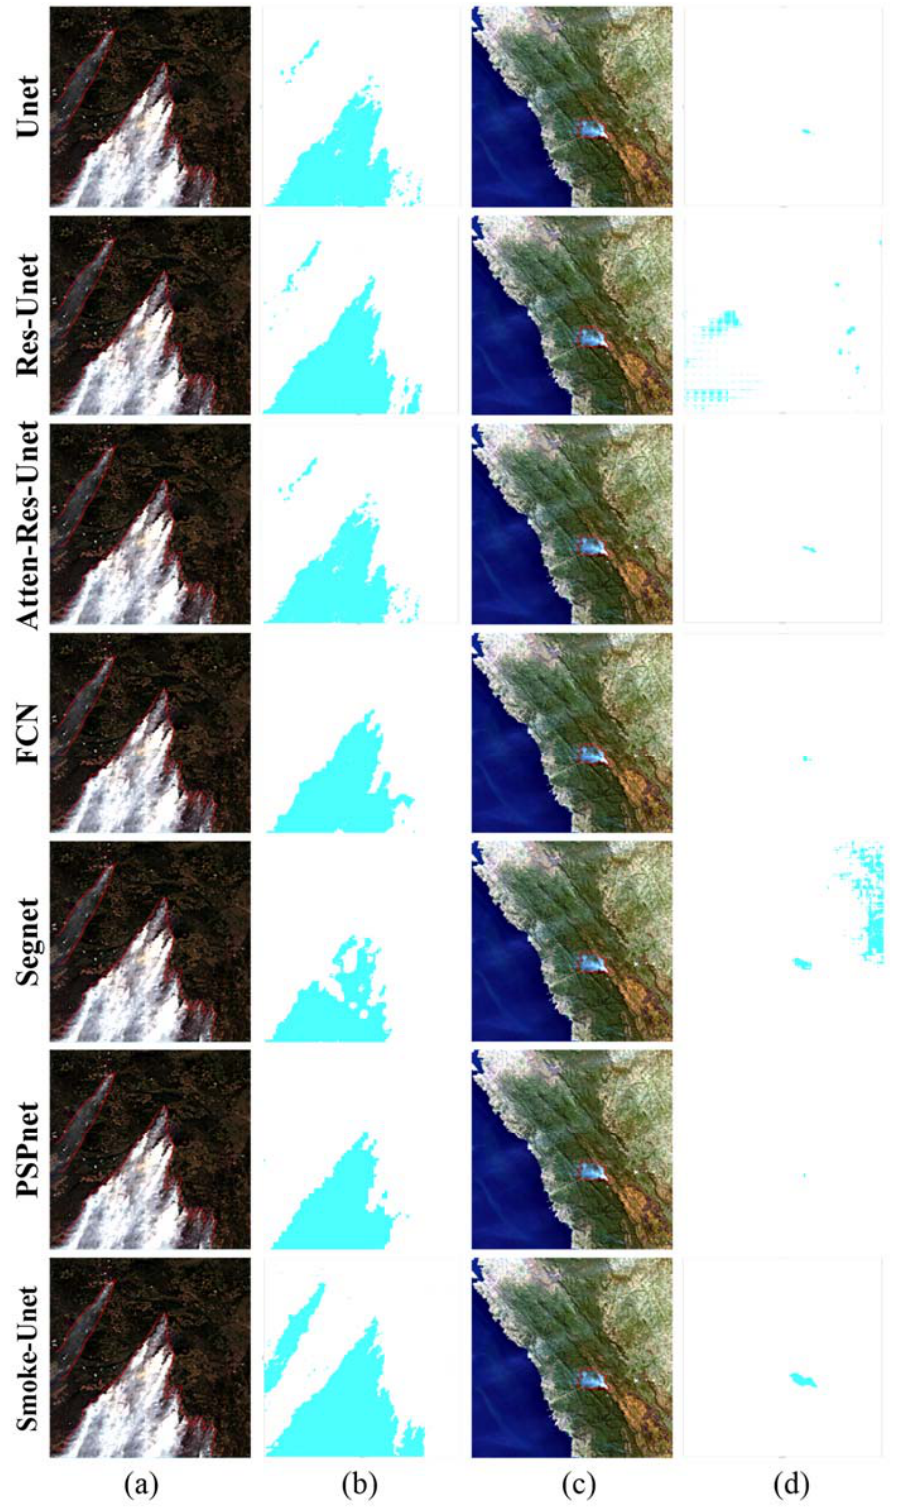
Figure 7. The results of segmentation of different networks. ( a ) Image acquired over British Columbia, Canada, on 4 August 2017, the smoke is depicted in red line area; ( b ) The segmentation results of smoke over British Columbia, the smoke pixels are depicted in aqua color; ( c ) Image acquired over New Zealand area, on 7 Feb 2019, the smoke is depicted in red line area; ( d ) The segmentation results of smoke over New Zealand area, the smoke pixels are depicted in aqua color.